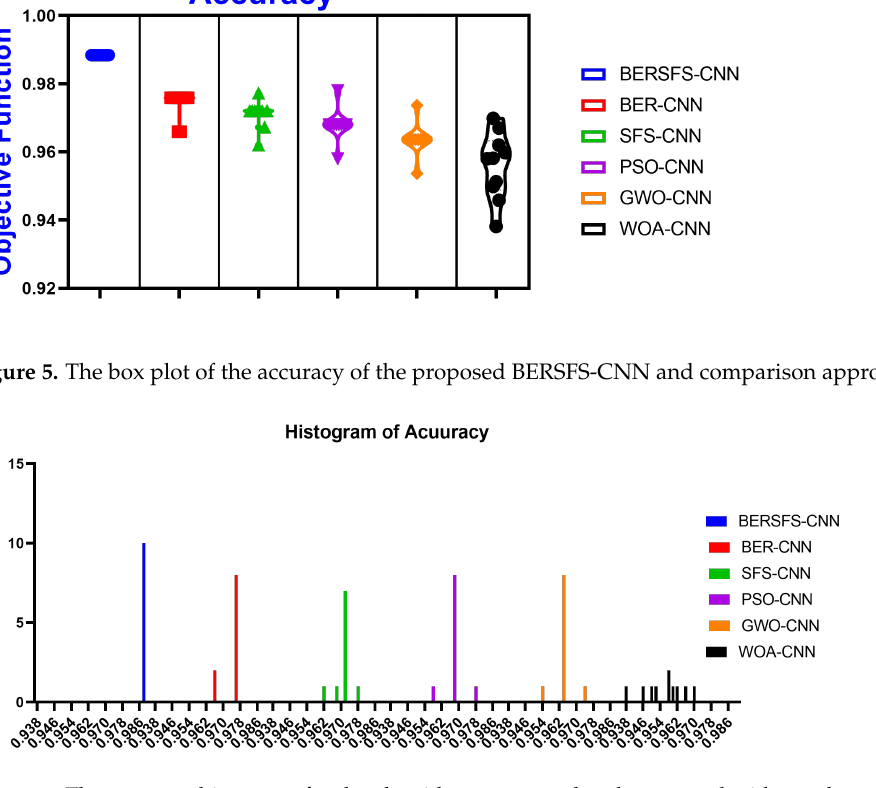
Figure 6. The accuracy histogram for the algorithms presented and compared with number of values in the bin center range